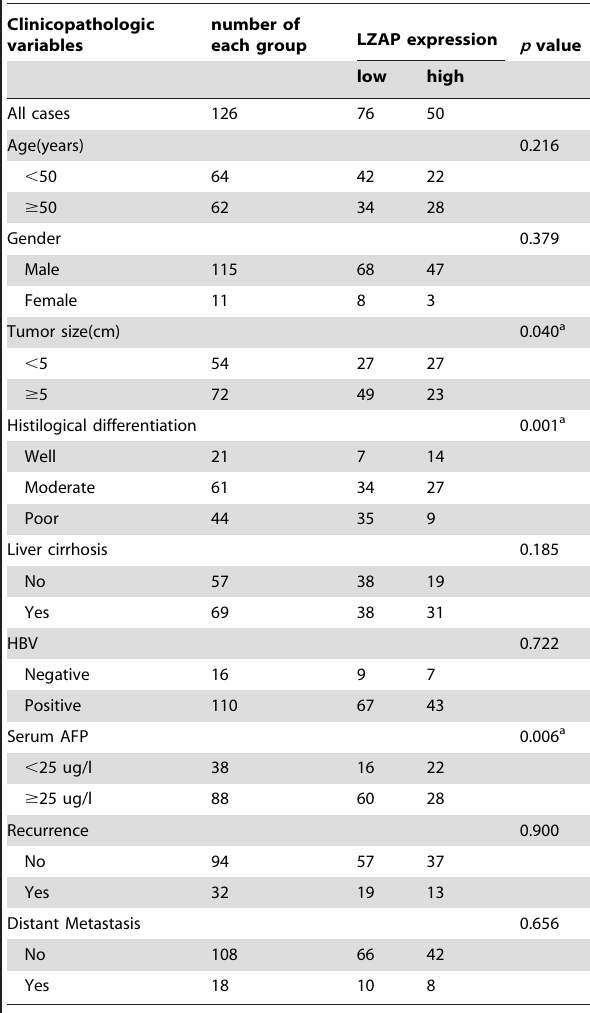
Table 1. Relationship between LZAP expression and clinicopathological features of 126 patients with hepatocellular